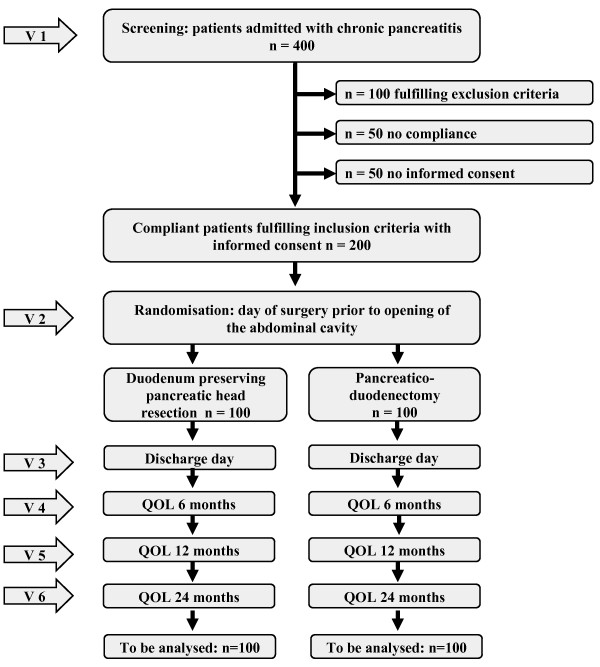
ChroPac study flow.